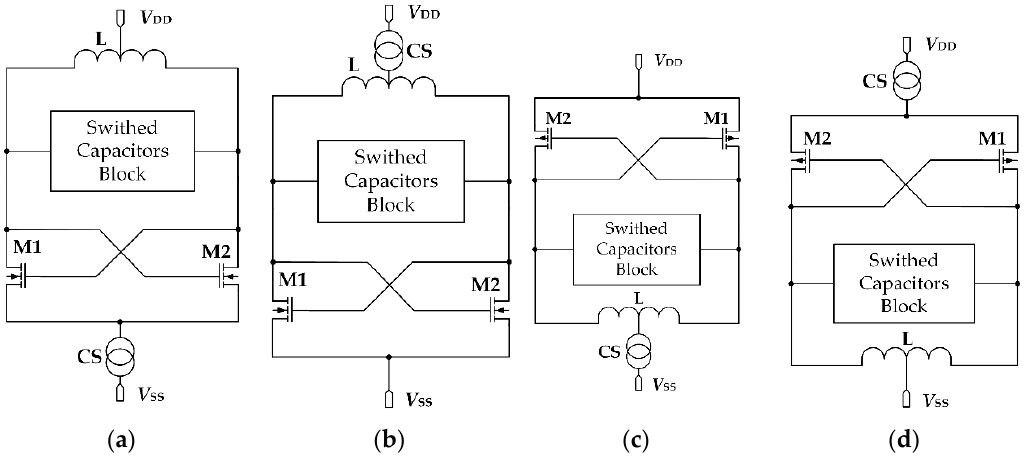
Figure 2. Simplified architecture of N-channel metal oxide semiconductor (NMOS) LC digitally controlled oscillator (LC DCO) cores: ( a ) current source (CS) connected to ground ( V SS ); ( b ) CS connected to supply ( V DD ). Simplified architecture of P-channel metal oxide semiconductor (PMOS) LC DCO cores: ( c ) CS connected to V SS ; ( d ) CS connected to V DD .